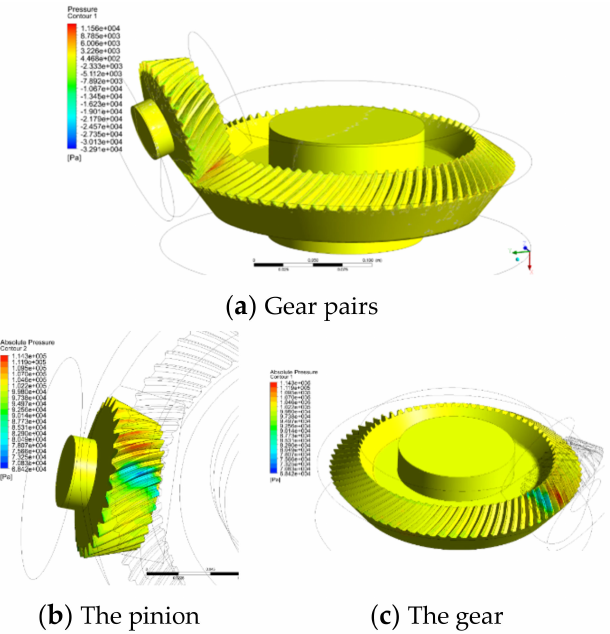
Figure 6. Pressure distribution of fluid on